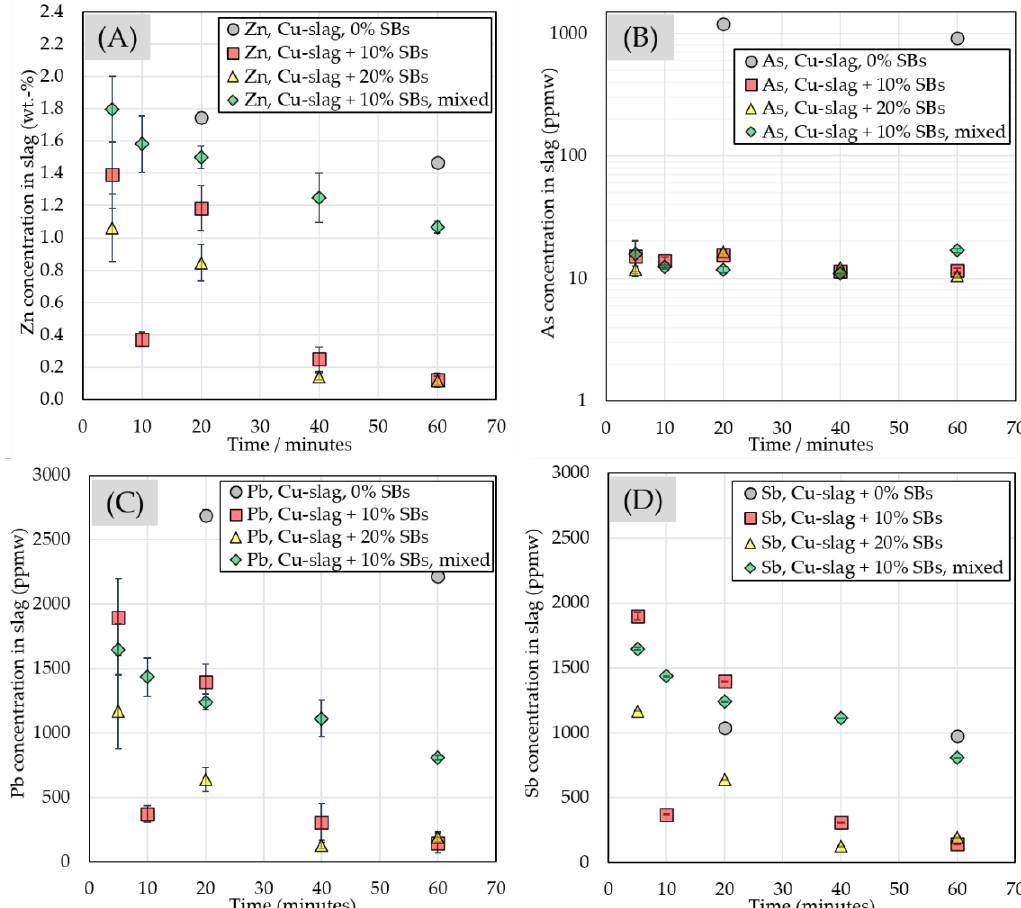
Figure 12. Concentration of trace elements Zn ( A ), As ( B ), Pb ( C ), Sb ( D ) in the slag as a function of contact time.